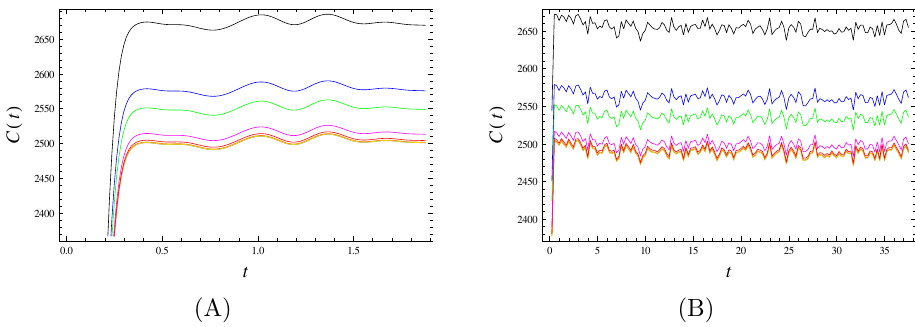
Figure 2. Numerically computed and averaged kinematic OTOC C ( t ) for an ensemble of l = 1000 Gaussian orthogonal matrices of size N = 60 for the deviation σ = 0 . 1 , at temperatures 0 . 67 (black), 1 . 00 (blue), 1 . 25 (green), 2 . 50 (magenta), 5 (red), 10 (orange), 20 (yellow) and 100 gray. In (B) we plot the same as in (A) but over a longer timescale, showing that the plateau remains stable for long times, i.e. represents true asymptotic behavior.